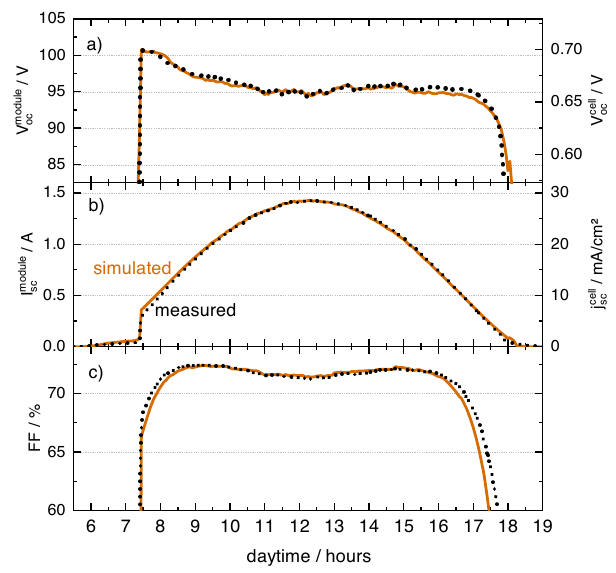
Fig. 4 Solar-module parameters during the daytime of September 9, 2020. The numbers on the right axis are cell values that are calculated from the module and the number of cells, while the actual measurement data of the module belongs to the left axis. While the open-circuit voltage V j oc stays rather constant, the short-circuit current sc nearly linearly follows the irradiance curve. The drops in the fi ll factor FF in the morning and evening can be explained by a low generation current, and the saddle at noontime is due to a high temperature and a huge current